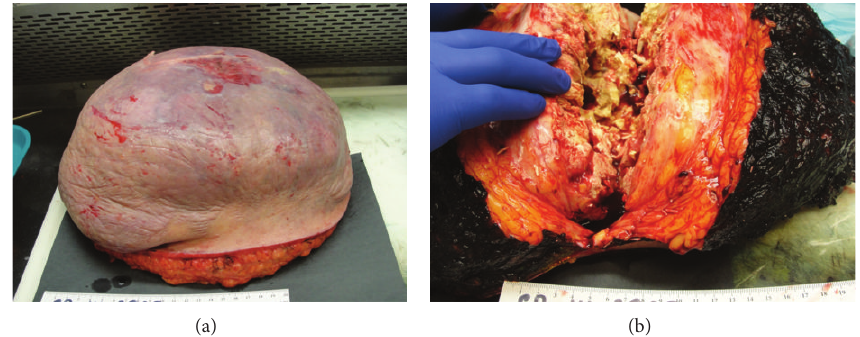
Figure 3: (a) The resected soft tissue mass from the back weighed 5634 grams. (b) Sectioning revealed a 24 cm well-circumscribed encapsulated firm mass centered in the dermis and extending to subcutaneous tissue. The mass demonstrated a central cavity with debris and pus.